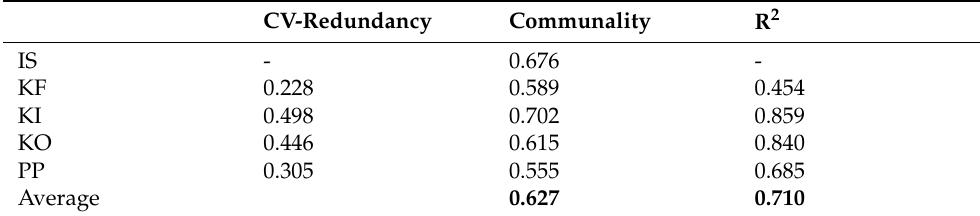
Table 6. CV-redundancy, communality, and R-squared